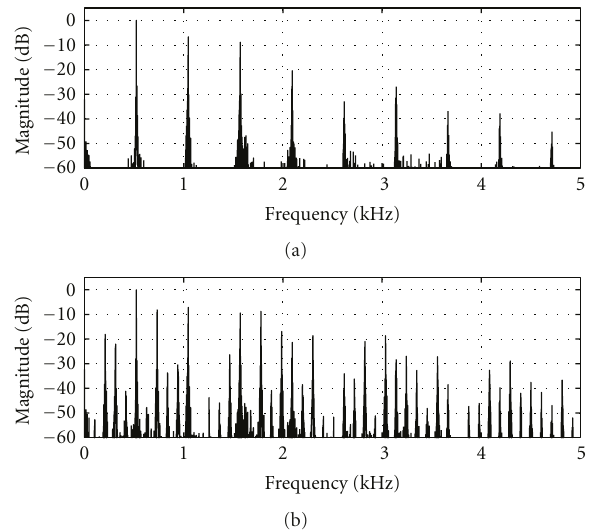
Figure 27: Spectra of (a) C4 flute tone and (b) its Adaptive FBAM- processed version, with the carrier-modulator ratio set to 1:2.4 and β = 0 .